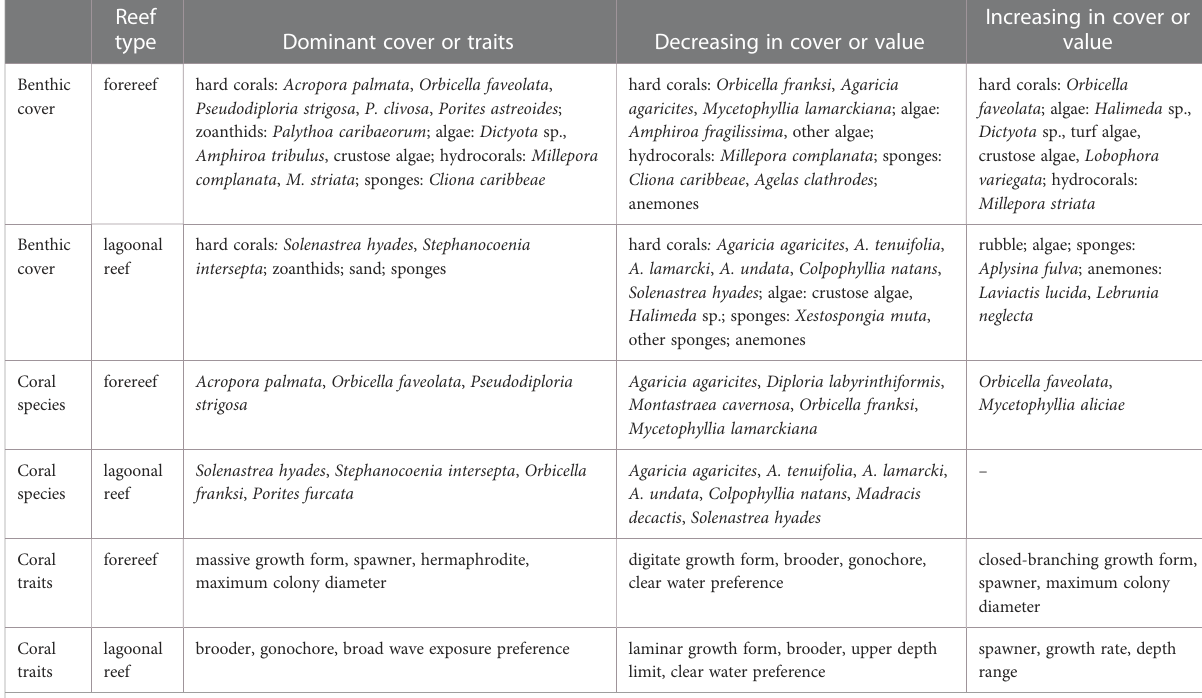
TABLE 1 Spatial and temporal variation in reef community composition. Dominant benthic cover, coral species, and traits shown are those with highest loading scores in PCoA and MFA ordination spaces.